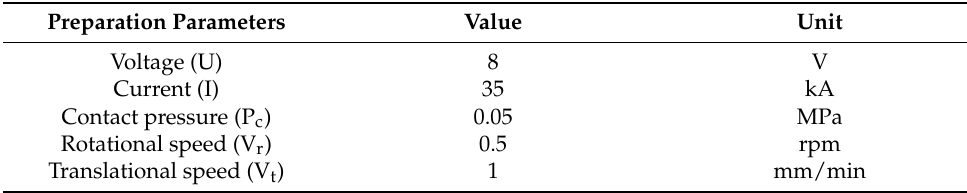
Figure 4. Macroscopic appearance in the ECS process: ( a ) substrate; ( b ) pre-coating; ( c ) formed coating. Table 3. Preparation parameters of